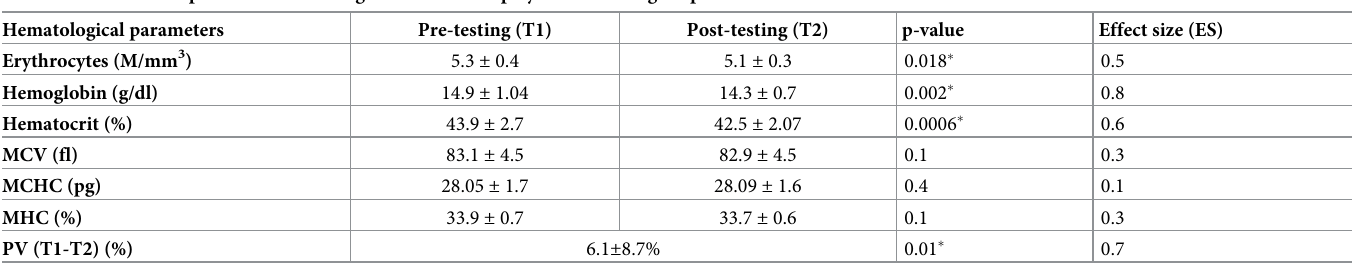
Table 4. Effects of the period of match congestion on soccer players’ hematological